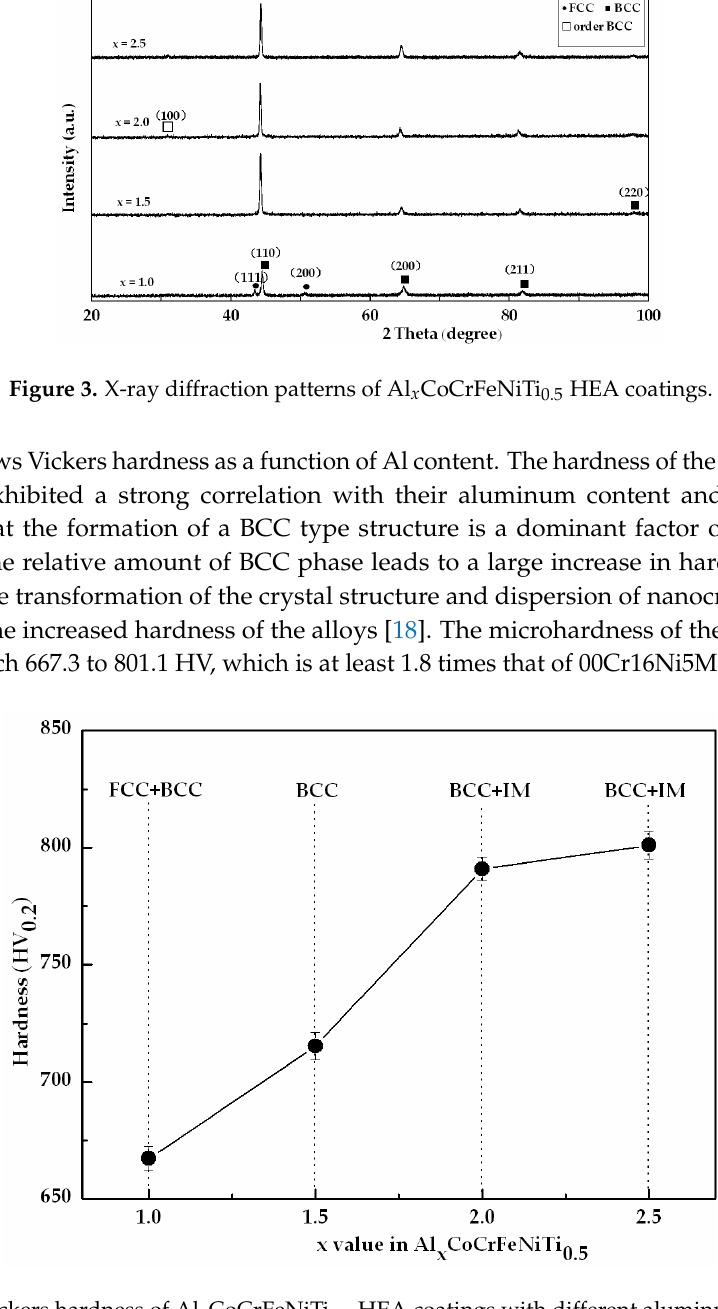
Figure 4. Vickers hardness of Al x CoCrFeNiTi 0.5 HEA coatings with different aluminum contents.